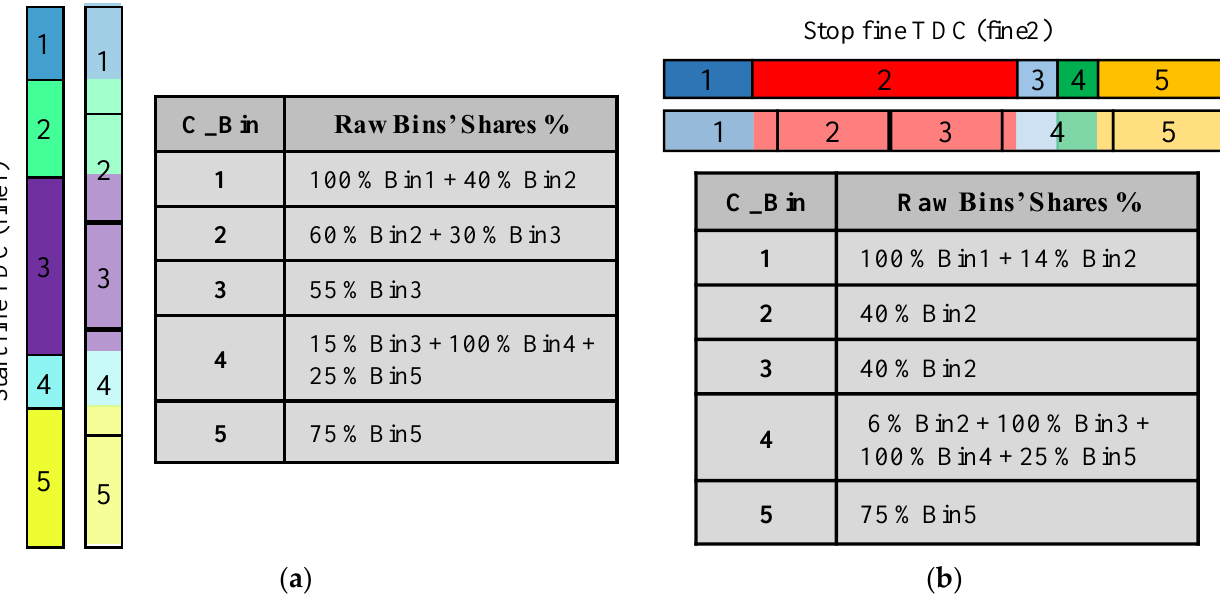
Figure 9. Individual calibration tables: ( a ) Start fine TDC calibration table; ( b ) Stop fine TDC calibration table.